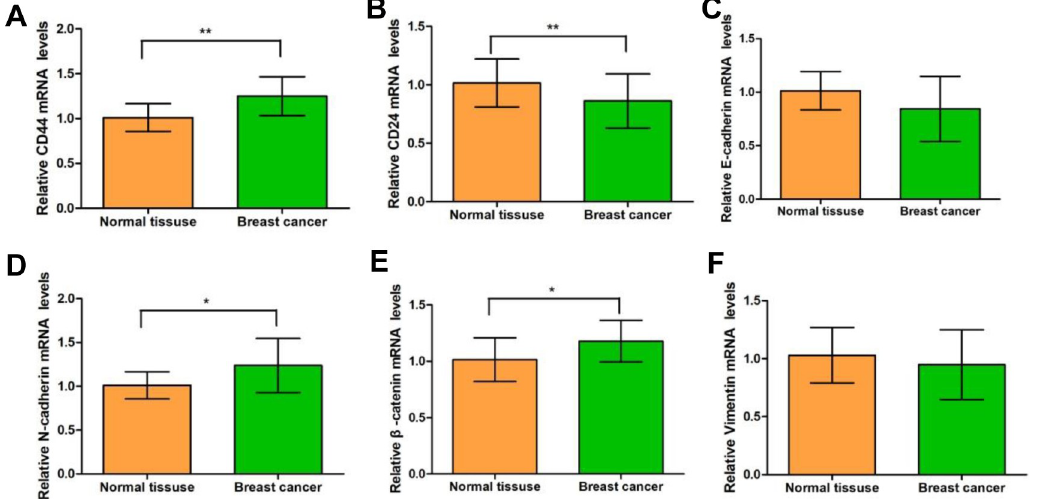
Fig 3. The mRNA expression levels of CSC-related and EMT-related genes in breast cancer tissues (n = 63). The mRNA expression levels of CD44 (A), CD24 (B), E-cadherin (C), N-cadherin (D), β -catenin (E), and Vimentin (F) were detected with the quantitative real-time PCR. Compared with the normal surrounding tissues, � P < 0.05, �� P < 0.01.